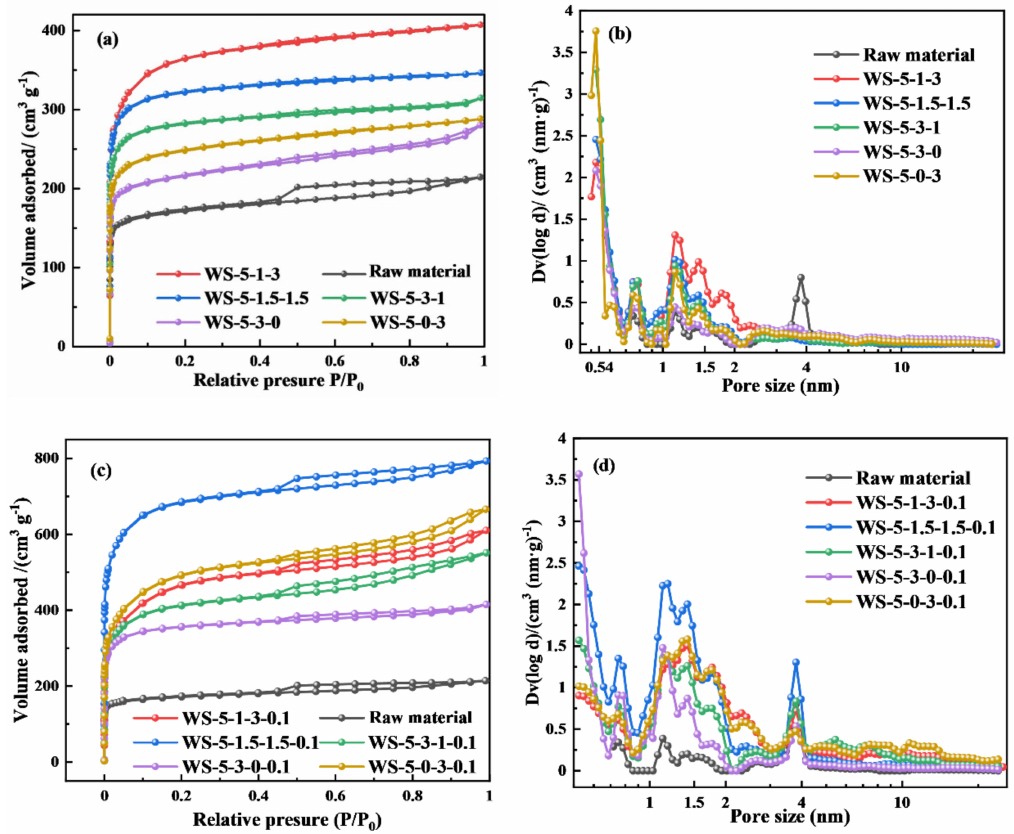
Figure 6. N 2 adsorption–desorption isotherms of ( a ) different ratios of metal salts activation and ( c ) different ratios of metal salts and 0.1 mL min − 1 H 2 O(g) activation. Pore size distribution of ( b ) different ratios of metal salts activation and ( d ) different ratios of metal salts and 0.1 mL min − 1 H 2 O(g)